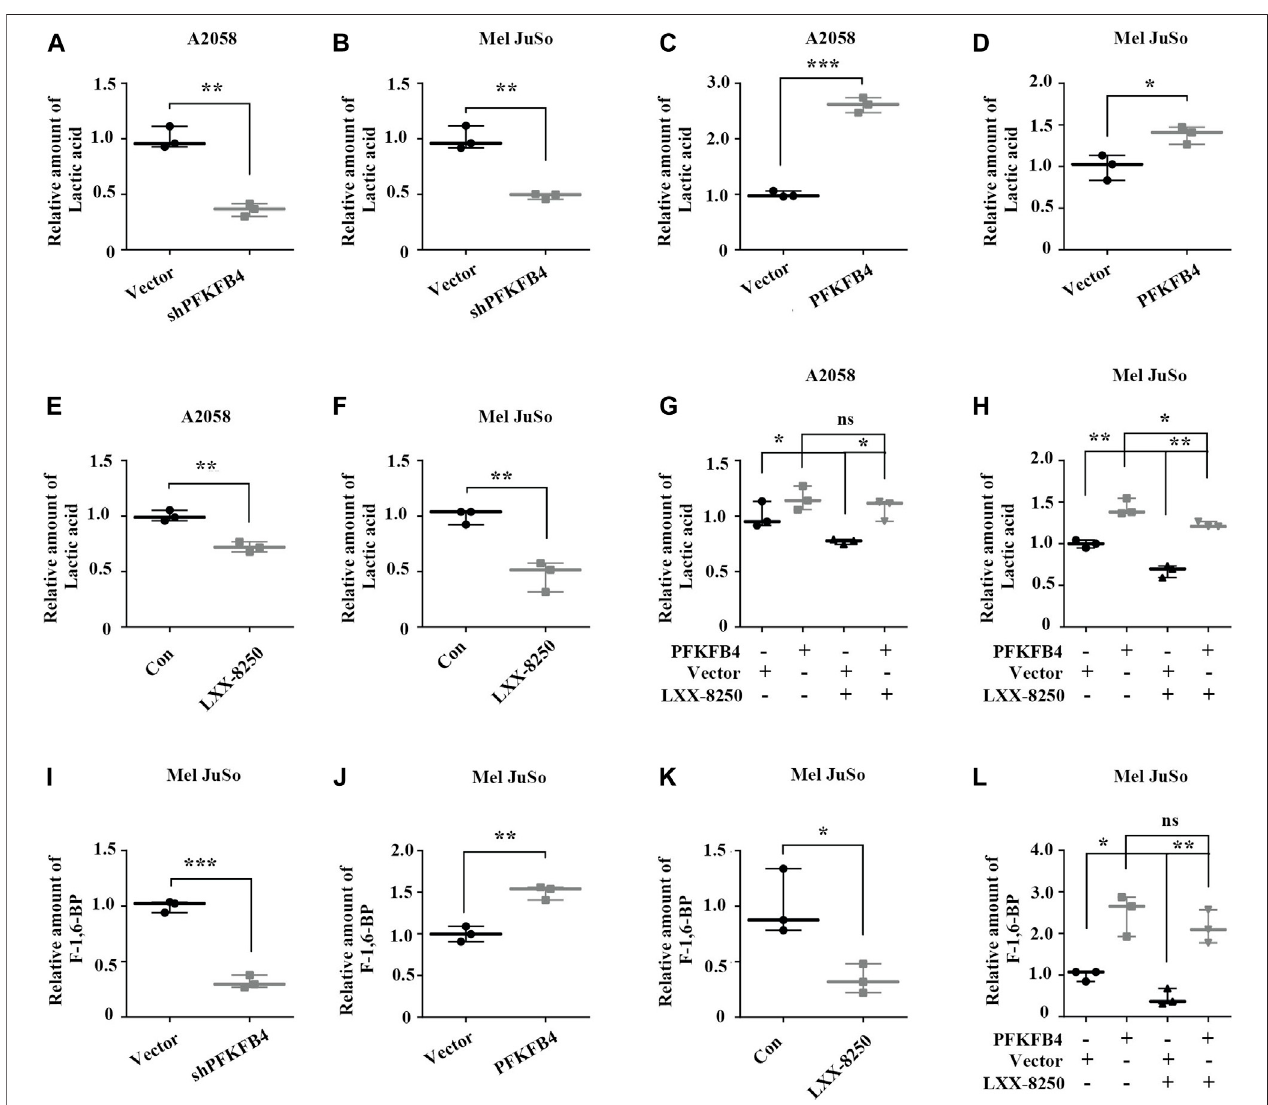
FIGURE 5 | Effects of LXX-8250 and PFKFB4 on lactic acid production. (A – H) Lactic acid analyses. The indicated cells were introduced with empty vector or PFKFB4 shRNA(shPFKFB4) (A,B) .TheindicatedcellswereintroducedwithemptyvectororPFKFB4overexpressionplasmid (C,D) .TheindicatedcellsweretreatedwithorwithoutLXX- 825014.6 μ M, (E) ;22.8 µM, (F)(E,F) .TheindicatedcellsintroducedwithemptyvectororPFKFB4overexpressionplasmidweretreatedwithorwithoutLXX-825014.6 μ M, (G) ; 22.8 µM, (H) for 24 h (G,H) . (I – L) F-1,6-BP analyses. The indicated cells were introduced with empty vector or PFKFB4 shRNA (shPFKFB4) (I) . The indicated cells were introducedwithemptyvectororPFKFB4overexpressionplasmid (J) .TheindicatedcellsweretreatedwithorwithoutLXX-825022.8 µM, (K) .Theindicatedcellsintroducedwith empty vector or PFKFB4 overexpression plasmid were treated with or without LXX-8250 22.8 µM, (L) for 24 h. Data represent mean ± SD. * p < 0.05, ** p < 0.01, *** p < 0.001.